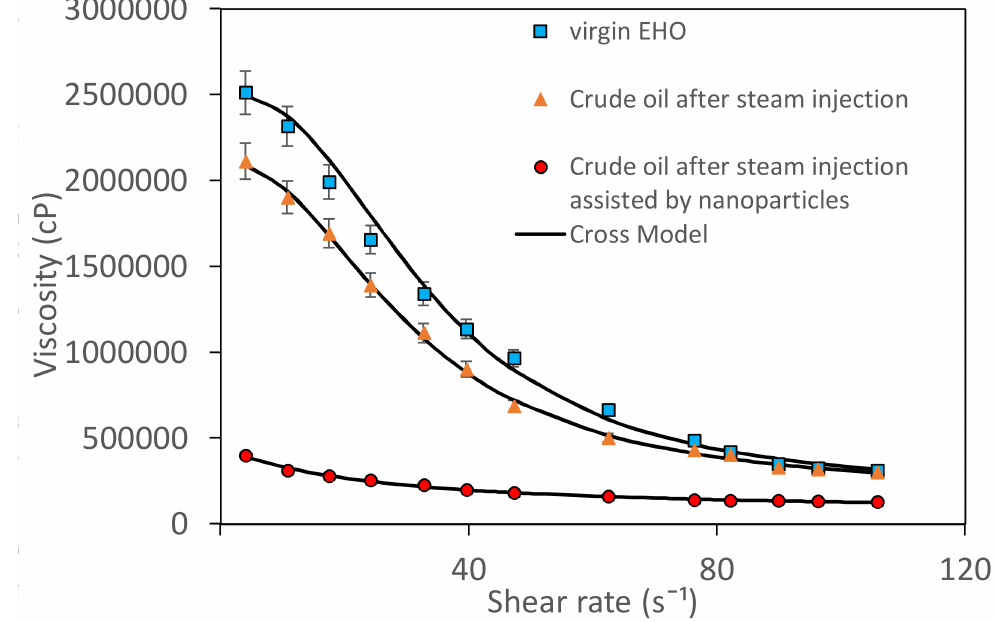
Figure 3. The rheological behavior of an extra heavy crude oil before and after recovery with steam injection in the presence and absence of 1000 mg/L of SiNi1Pd1 nanoparticles. Injection pressure and temperature were maintained at 8.96 MPa (1300 psi) and 300 ◦ C, respectively. The points are the experimental data and the continuous line is the Cross model in Equation